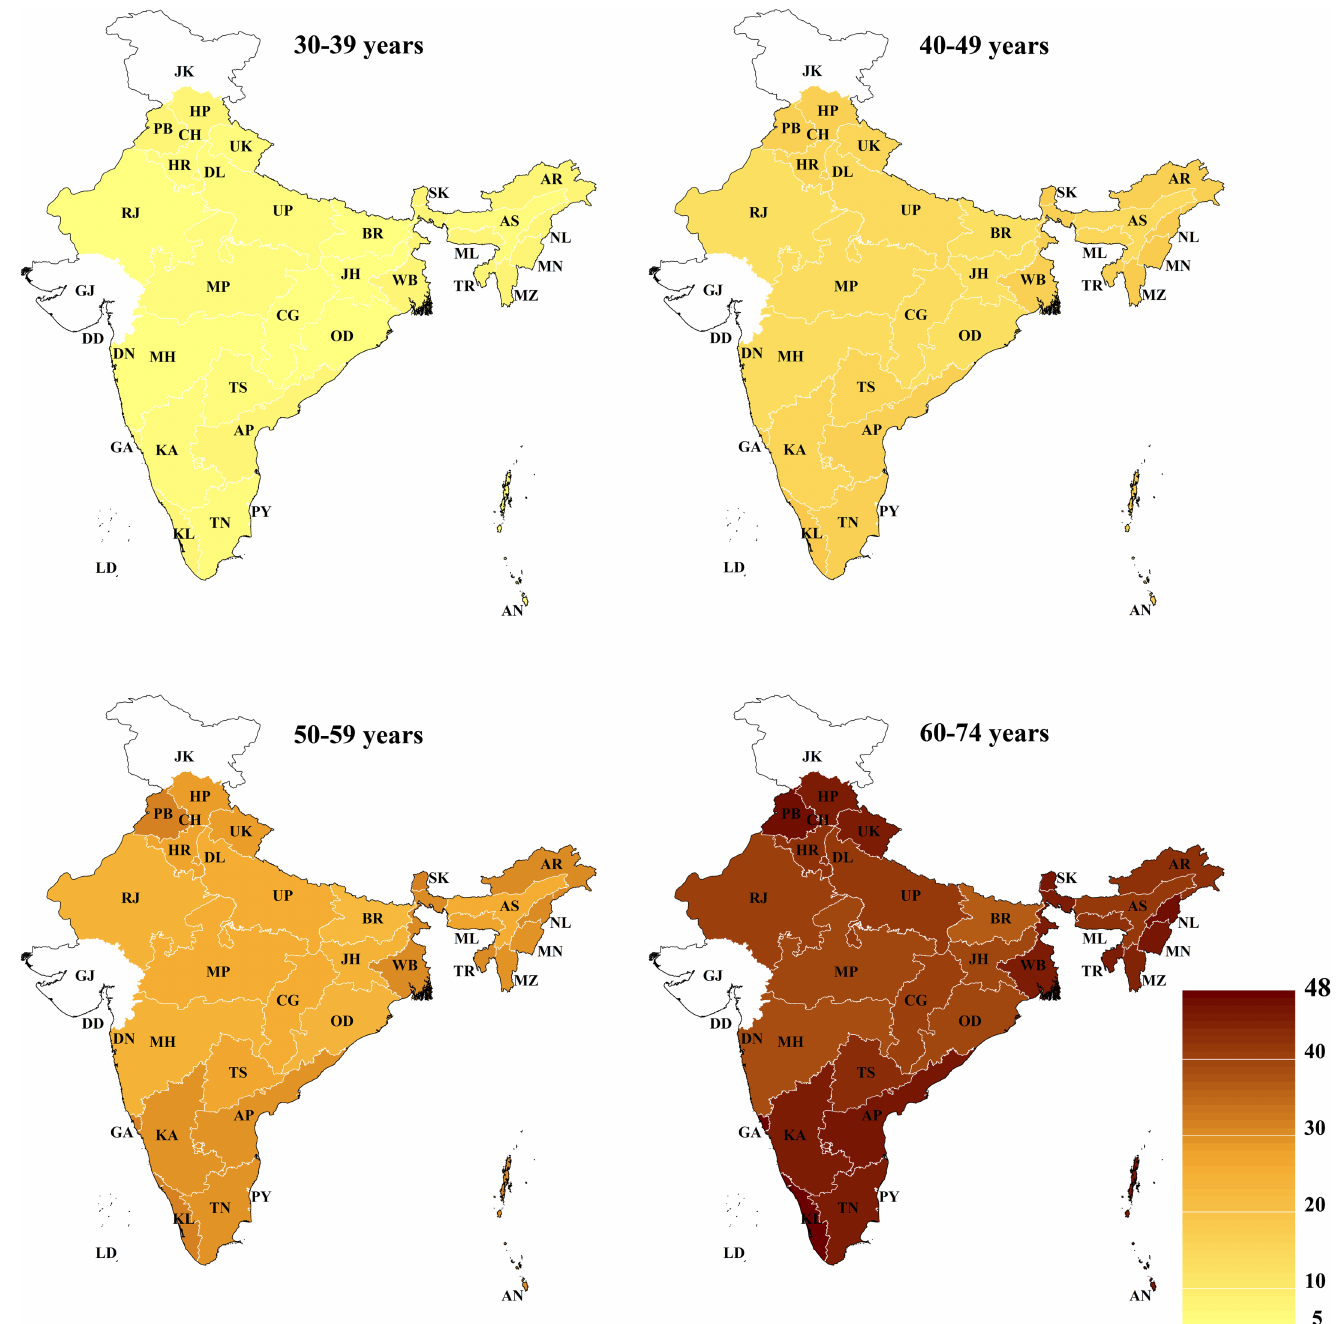
Fig 2. Age-standardized state-level mean 10-year risk of a cardiovascular disease event (percent as calculated by the Framingham risk score), by age group. The Global Burden of Disease project’s 2013 population for India was used for age standardization [36]. No data were available for Gujarat and Jammu and Kashmir. AN, Andaman and Nicobar Islands; AP, Andhra Pradesh; AR, Arunachal Pradesh; AS, Assam; BR, Bihar; CG, Chhattisgarh; CH, Chandigarh; DD, Daman and Diu; DL, Delhi; DN, Dadra and Nagar Haveli; GA, Goa; GJ, Gujarat; HR, Haryana; HP, Himachal Pradesh; JH, Jharkhand; JK, Jammu and Kashmir; KA, Karnataka; KL, Kerala; LD, Lakshadweep; MP, Madhya Pradesh; MH, Maharashtra; MN, Manipur; ML, Meghalaya; MZ, Mizoram; NL, Nagaland; OD, Odisha (Orissa); PB, Punjab; PY, Puducherry; RJ, Rajasthan; SK, Sikkim; TN, Tamil Nadu; TS, Telangana State; TR, Tripura; UP, Uttar Pradesh; UK, Uttarakhand (Uttaranchal); WB, West Bengal.